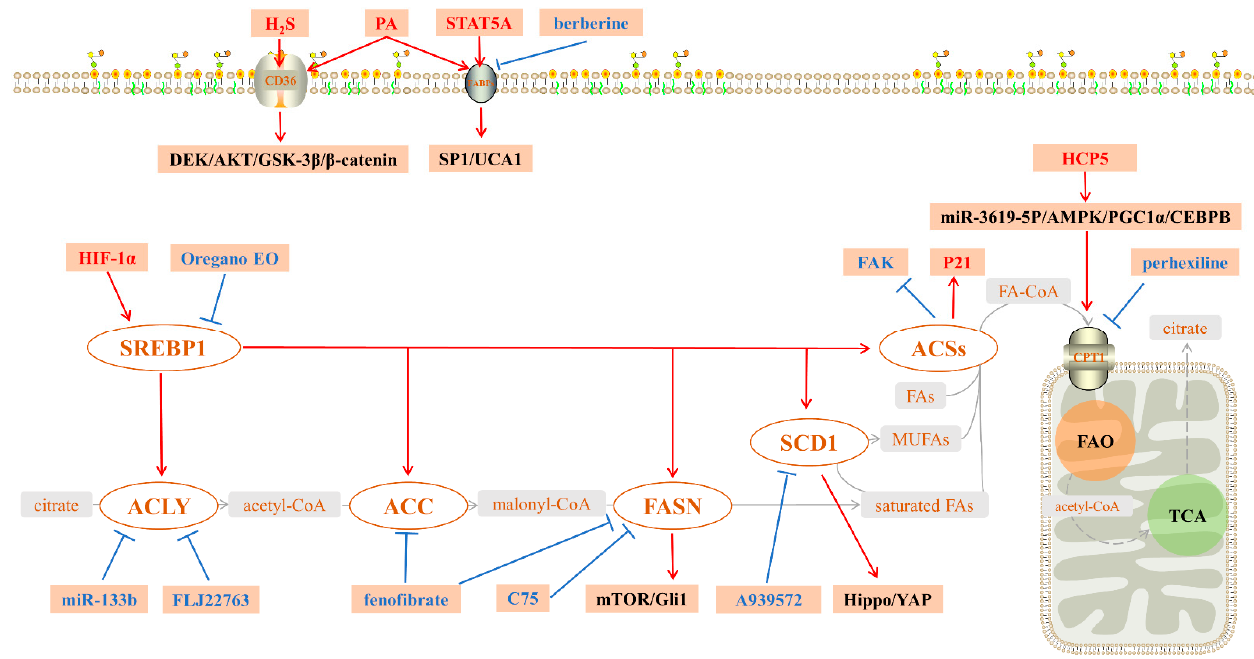
Figure 1. Fatty acid metabolism in GC. Citrate by TCA enters the cytoplasm and is converted to acetyl-CoA by ACLY, then ACC converts acetyl-CoA to malonyl-CoA. Malonyl-CoA is used by FASN as a direct substrate for the DNL to synthesize saturated fatty acids (usually PA). SCD1 is capable of converting saturated fatty acids to MUFAs. ACSs play two main roles in fatty acid metabolism: one is to convert free fatty acids to acetyl-CoA, thus participating in fatty acid synthesis; the other is to convert fatty acids to FA-CoA to be transferred to mitochondria by CPT1 for further oxidative catabolism. SREBP1 regulates the expression of ACLY, ACC, FASN, SCD1, and ACSs at the transcriptional level. CD36 and FABPs are responsible for the uptake of exogenous PA, involved in fatty acid metabolic processes in the cytoplasm. In gastric cancer, FASN promotes the mTOR/Gli1 pathway, SCD1 promotes the Hippo/YAP pathway, CD36 promotes the DEK/AKT/GSK-3 β / β -catenin pathway, FABPs promote the SP1/UCA1 pathway, and HCP5 targets miR-3619-5p to upregulate PPARGC1A, leading to the transactivation of CPT1 by the PGC1 α /CEBPB complex. SREBP1: sterol regulatory element-binding protein 1; ACLY: ATP citrate lyase; ACC: acetyl-CoA